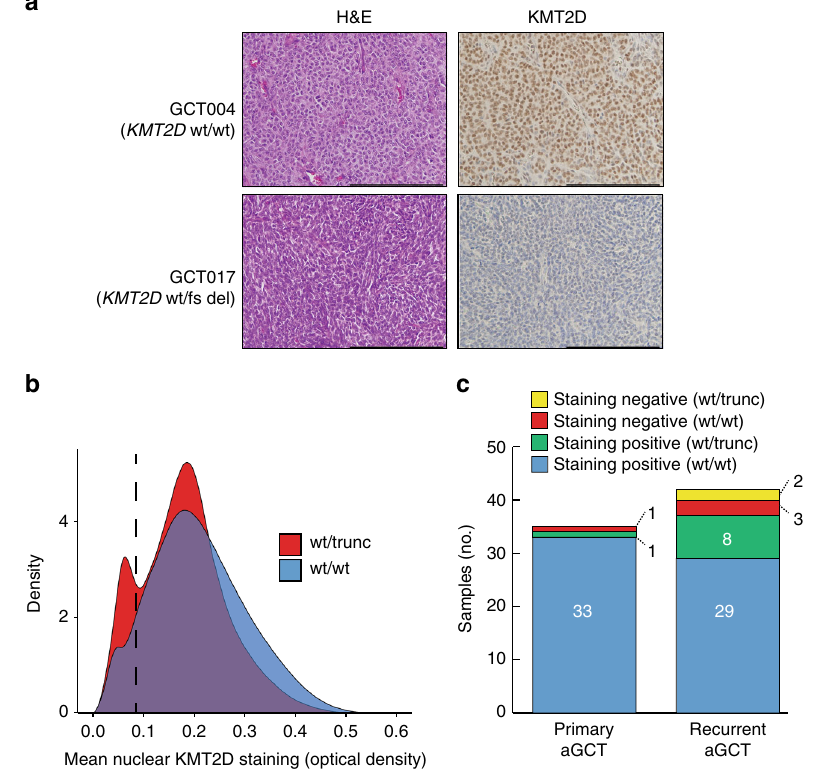
Fig. 3 Nuclear KMT2D expression in primary and recurrent aGCTs. a Representative stained sections from tumors with positive (GCT004) and negative (GCT017) nuclear KMT2D expression. Scale bar = 200 μ m. b Density plot of per nucleus mean KMT2D staining by KMT2D mutation status. Plots were derived from measurements made from individual nuclei in KMT2D wt/trunc ( n = 1,964,133 nuclei) and KMT2D wt/wt ( n = 12,121,768) tumors. Dotted line indicates numerical cutoff to distinguish “ negative ” from “ positive ” nuclei (see Methods). c Relationship between mono-allelic KMT2D- truncating mutation and loss of KMT2D protein expression by tumor type. fs: frameshift mutation, trunc: truncating mutation (any